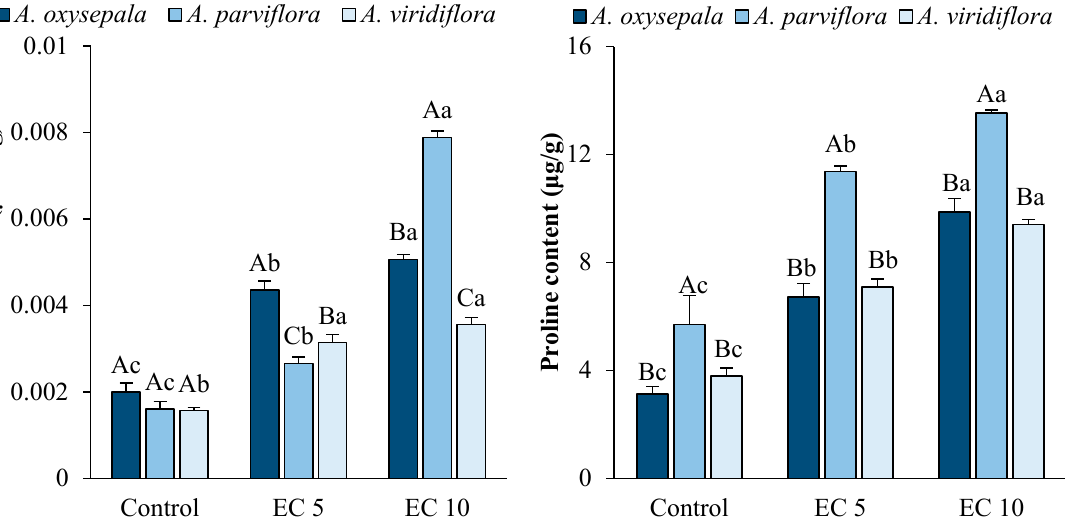
Figure 6. Malondiadehde (MDA) and proline contents of A. oxysepala , A. parviflora , and A. viridiflora irrigated with tap water (control) and salt solution at an electrical conductivity (EC) of 5 dS · m − 1 (EC 5) and 10 dS · m − 1 (EC 10). According to Tukey’s variance and analysis at p < 0.05, means with the same uppercase letters are not significantly changed among different species under the same treatment, and means with the same lowercase letters are not significantly changed among different treatments in the same species. Vertical bars represent standard error (SE).